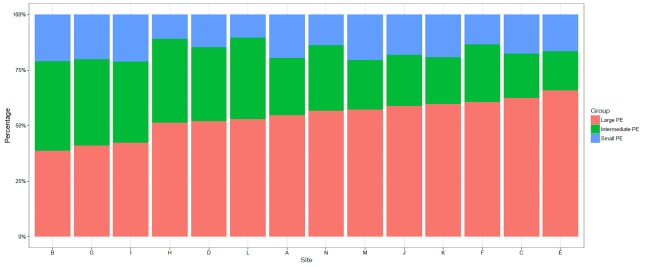
Proportion of small, intermediate and large PE as % of all PE at each site.